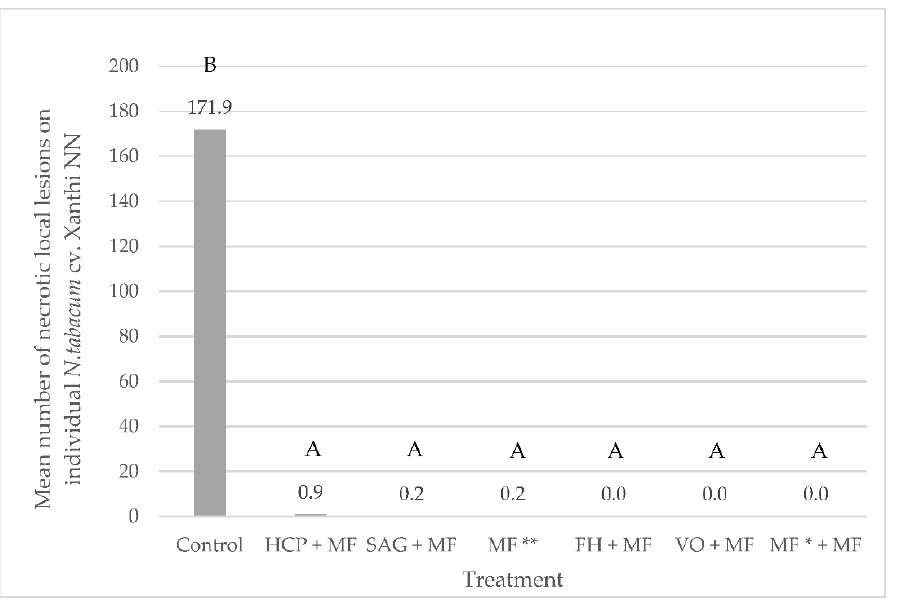
Figure 6. Evaluation of the residual infectivity of Tomato brown rugose fruit virus in the various cleaning solutions generated during the cleaning of ToBRFV-contaminated clothing after the addition of the disinfectant Menno Florades (4%) for 16 h by counting the number of necrotic local lesions on leaf halves of N. tabacum cv. Xanthi NN. Letters based on pairwise treatment comparisons using generalized linear mixed model analysis of count data (alpha = 0.05, with Bonferroni correction). n = 24. ‘Control’ = Deionized water with ToBRFV-contaminated fabric; ‘SAG’ = Spee Activ Gel; ‘VO’ = Vanish Oxi Action Gel; ‘MF’ = Menno Florades; ‘FH’ = Fadex H + ; ‘HCP’ = Hortisept Clean Plus. * 10 min contact time; ** 4 h contact time.